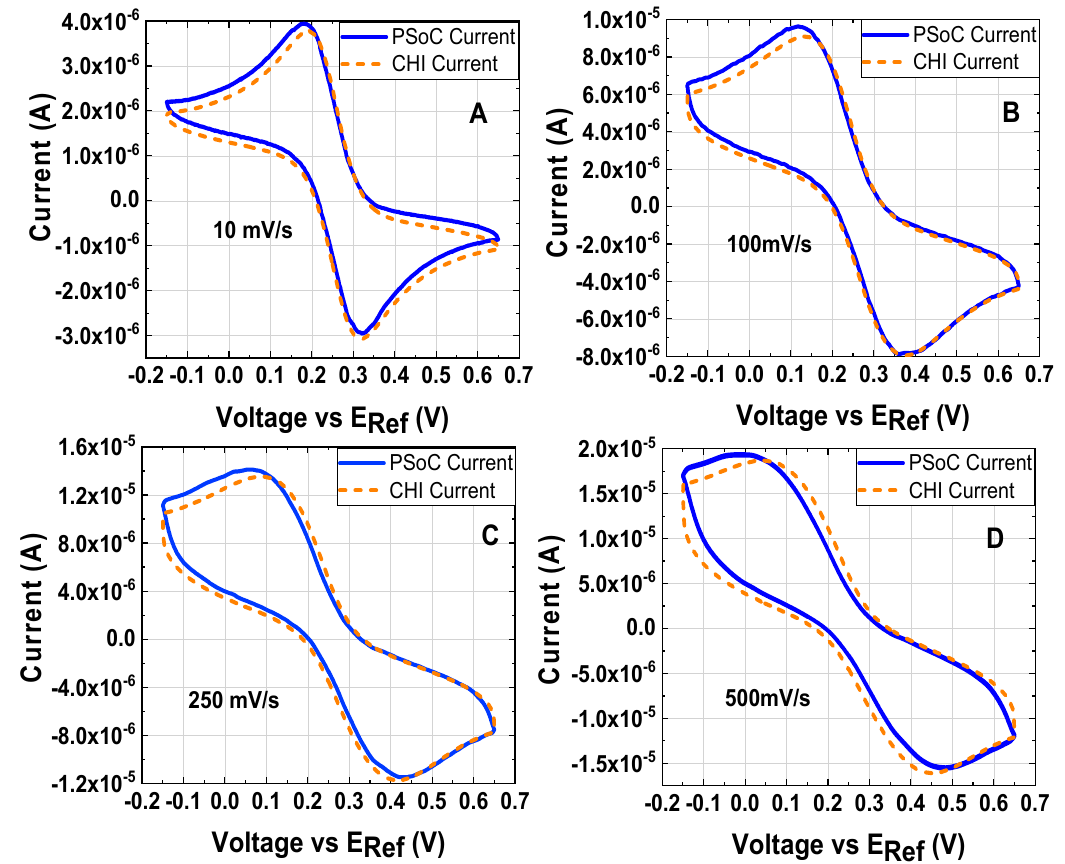
Figure 6. Cyclic voltammetry at different scan rates of 1 mM K ₃ [Fe(CN) ₆ ] and 0.5 M KCl as the electrolyte support; the working electrode, the counter electrode and the reference electrode were a disk glassy carbon electrode (diameter ϕ = 3 mm), a platinum wire and Ag/AgCl electrode, respectively: ( A ) 10 mV/s (experiment under the conditions 1). ( B ) 100 mV/s (experiment under the conditions 2). ( C ) 250 mV/s (experiment under the conditions 3). ( D ) 500 mV/s (experiment under the conditions